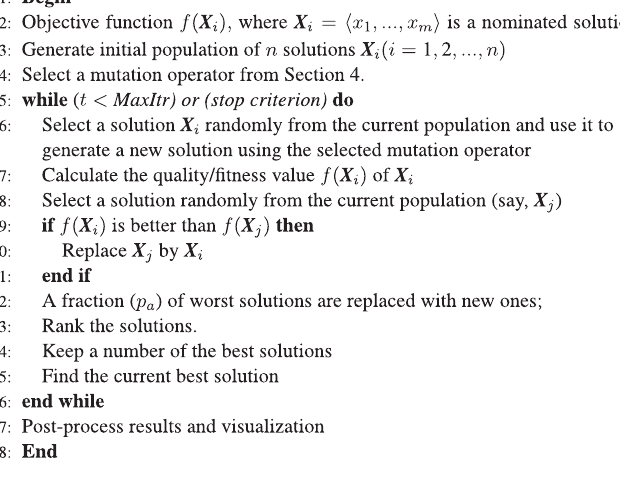
Figure 2: CS with Mutation.